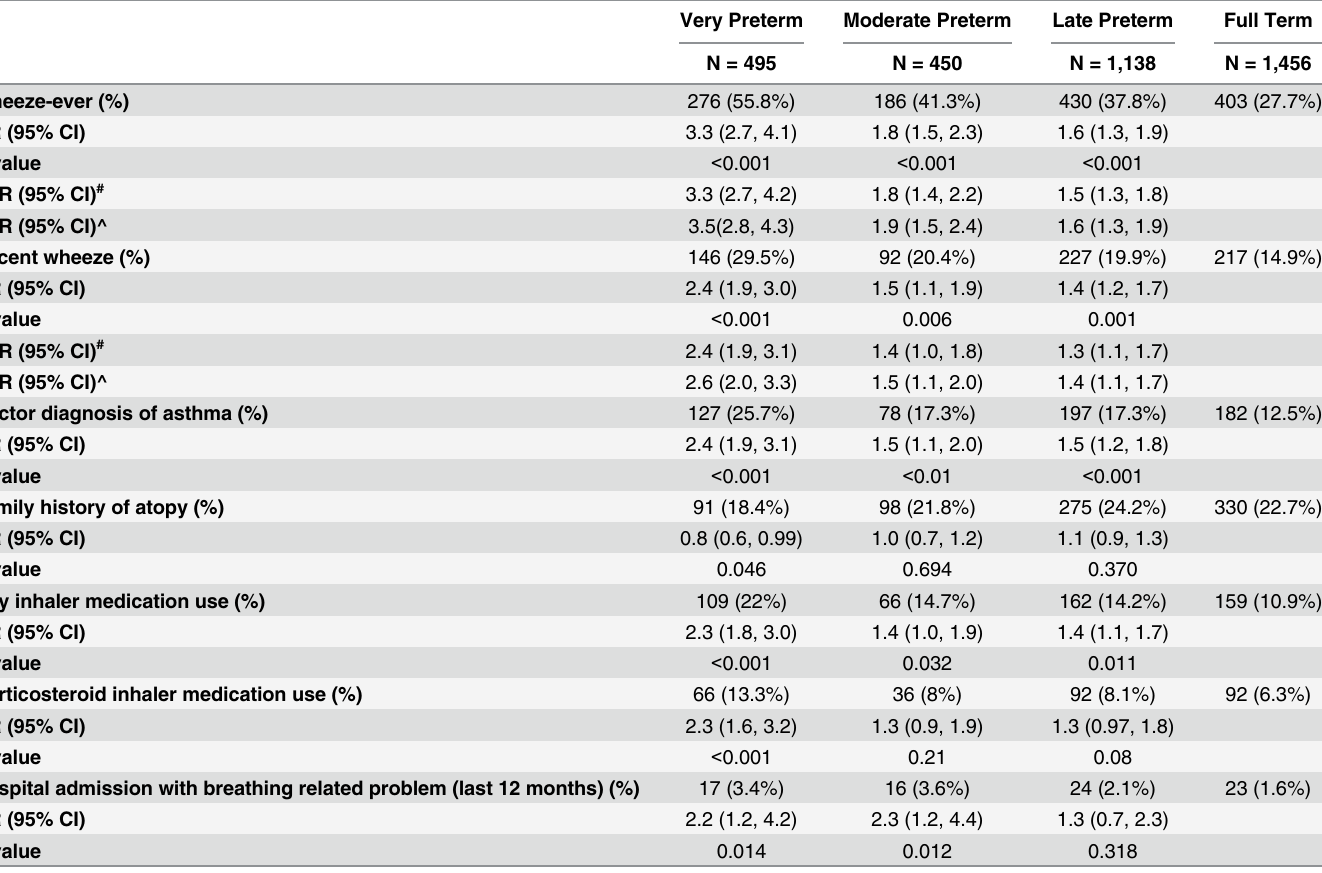
Table 4. Childhood wheezing, family history, inhaler use and hospital admissions for all children 5 years-of-age and older compared by gesta- tional age (unadjusted OR).